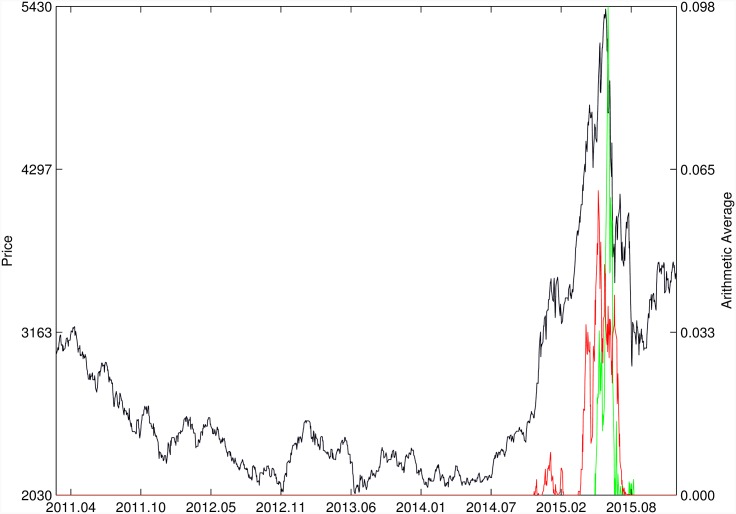
SSEC 2015.Same as Fig 10.